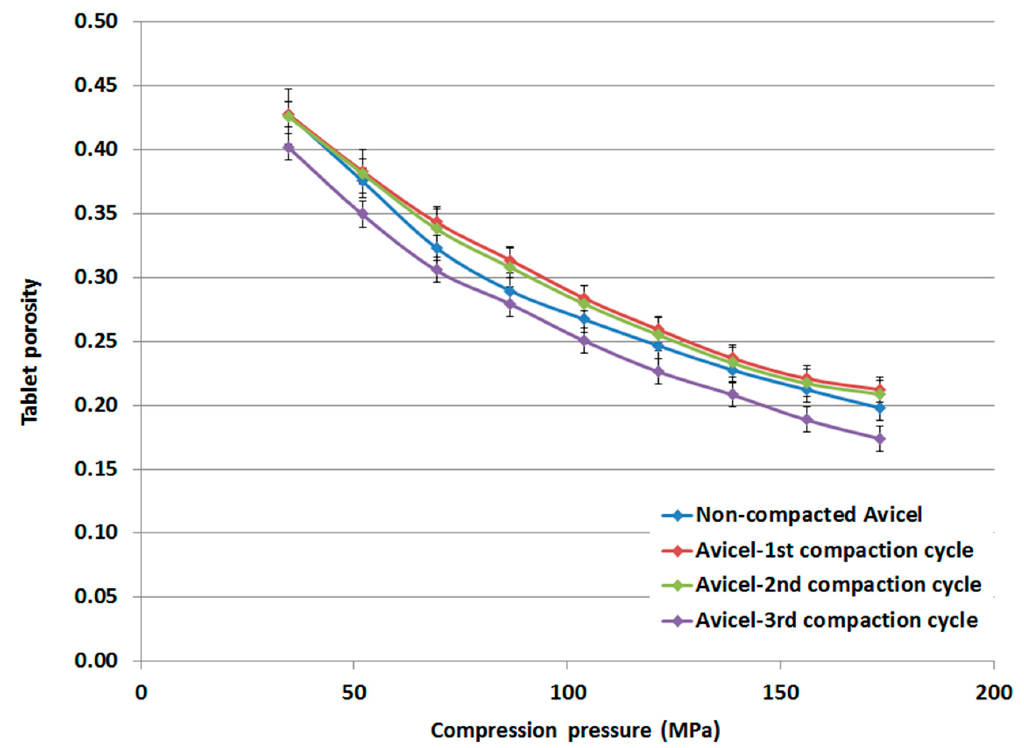
Figure 9. Porosity of tablets made of non-compacted and compacted Avicel PH-101.